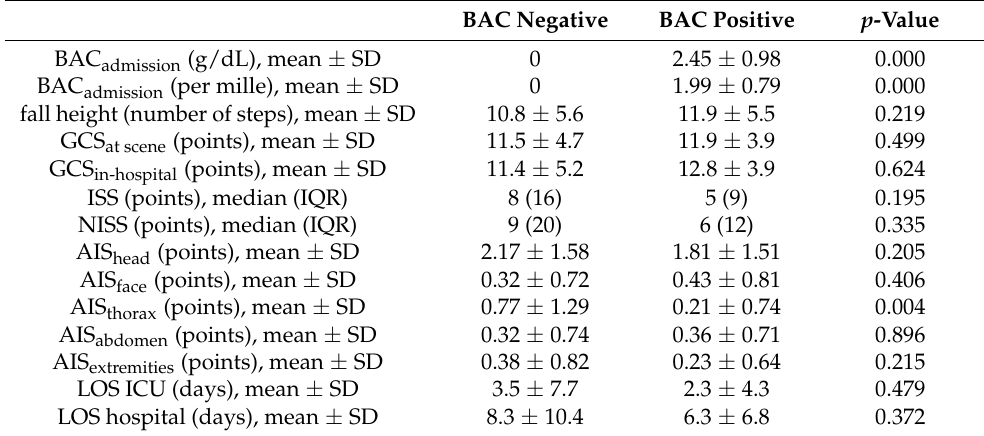
Table 5. Comparison between patients under the influence of alcohol and patients not under the influence of alcohol.